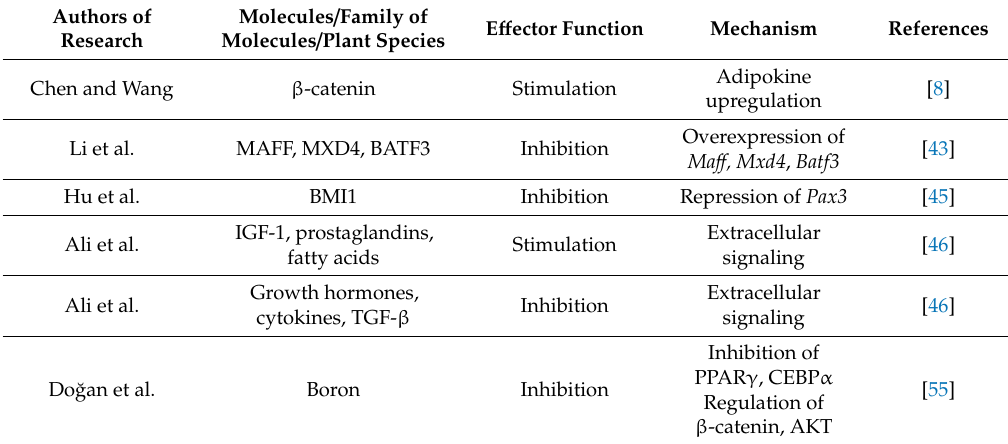
Table 1. Functional significance of internal and external molecular regulators of adipocyte proliferation including varying impact of biological and chemical reagents. The e ff ector function of a particular molecule, such as inhibition or stimulation is determined and supplemented accordingly by the following mechanisms and signaling pathways.